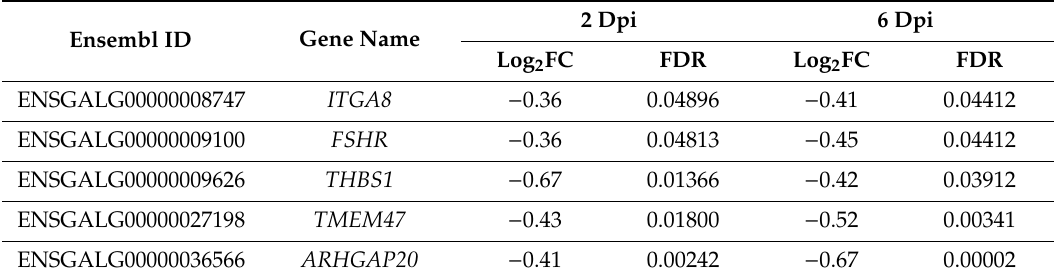
Table1. SharedDEGs( p < 0.05)forNDV-challengedvs. Non-challengedat2and6dayspostinoculation.